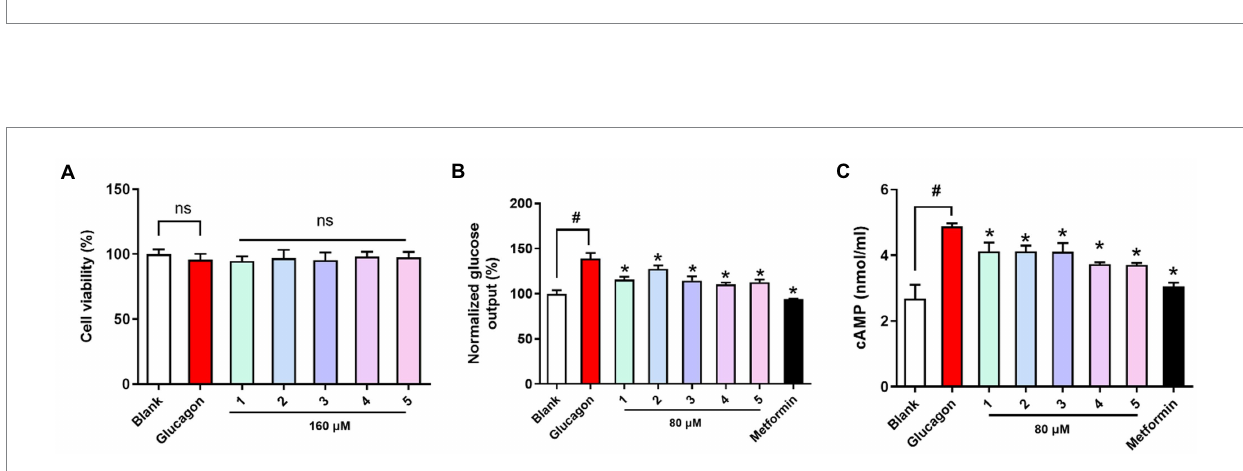
FIGURE 5 Viability and antidiabetic effects of compounds 1 - 5 against primary hepatocytes. (A) Cell viability (B) hepatic glucose output level; (C) cAMP contents in primary hepatocytes treated with glucagon (100 nM). Metformin (1 mM) as the positive control. ns p > 0.05 vs. Blank, * p < 0.05 vs. Glucagon, # p < 0.05 vs.